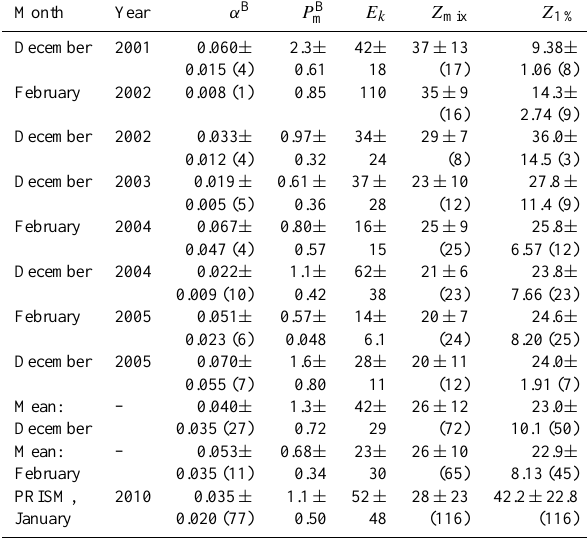
Table 2. Mean and standard deviations of photosynthesis– irradiance parameters, mixed-layer depths ( Z mix ) , and euphotic zone depths ( Z 1% ) determined during IVARS and PRISM